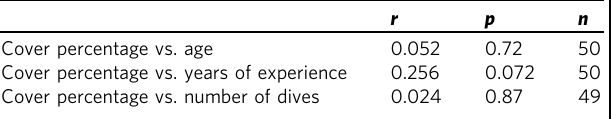
Table 4 Pearson ’ s correlation coef fi cients ( r ) and levels of signi fi cance ( p ) for the correlations between the cover percentage and age, years of experience, and number of dives. For the Florida Keys, what should the baseline cover percentage for stony corals be (on average throughout the keys, bank reef, and buttress zone at a depth of 10 m)?